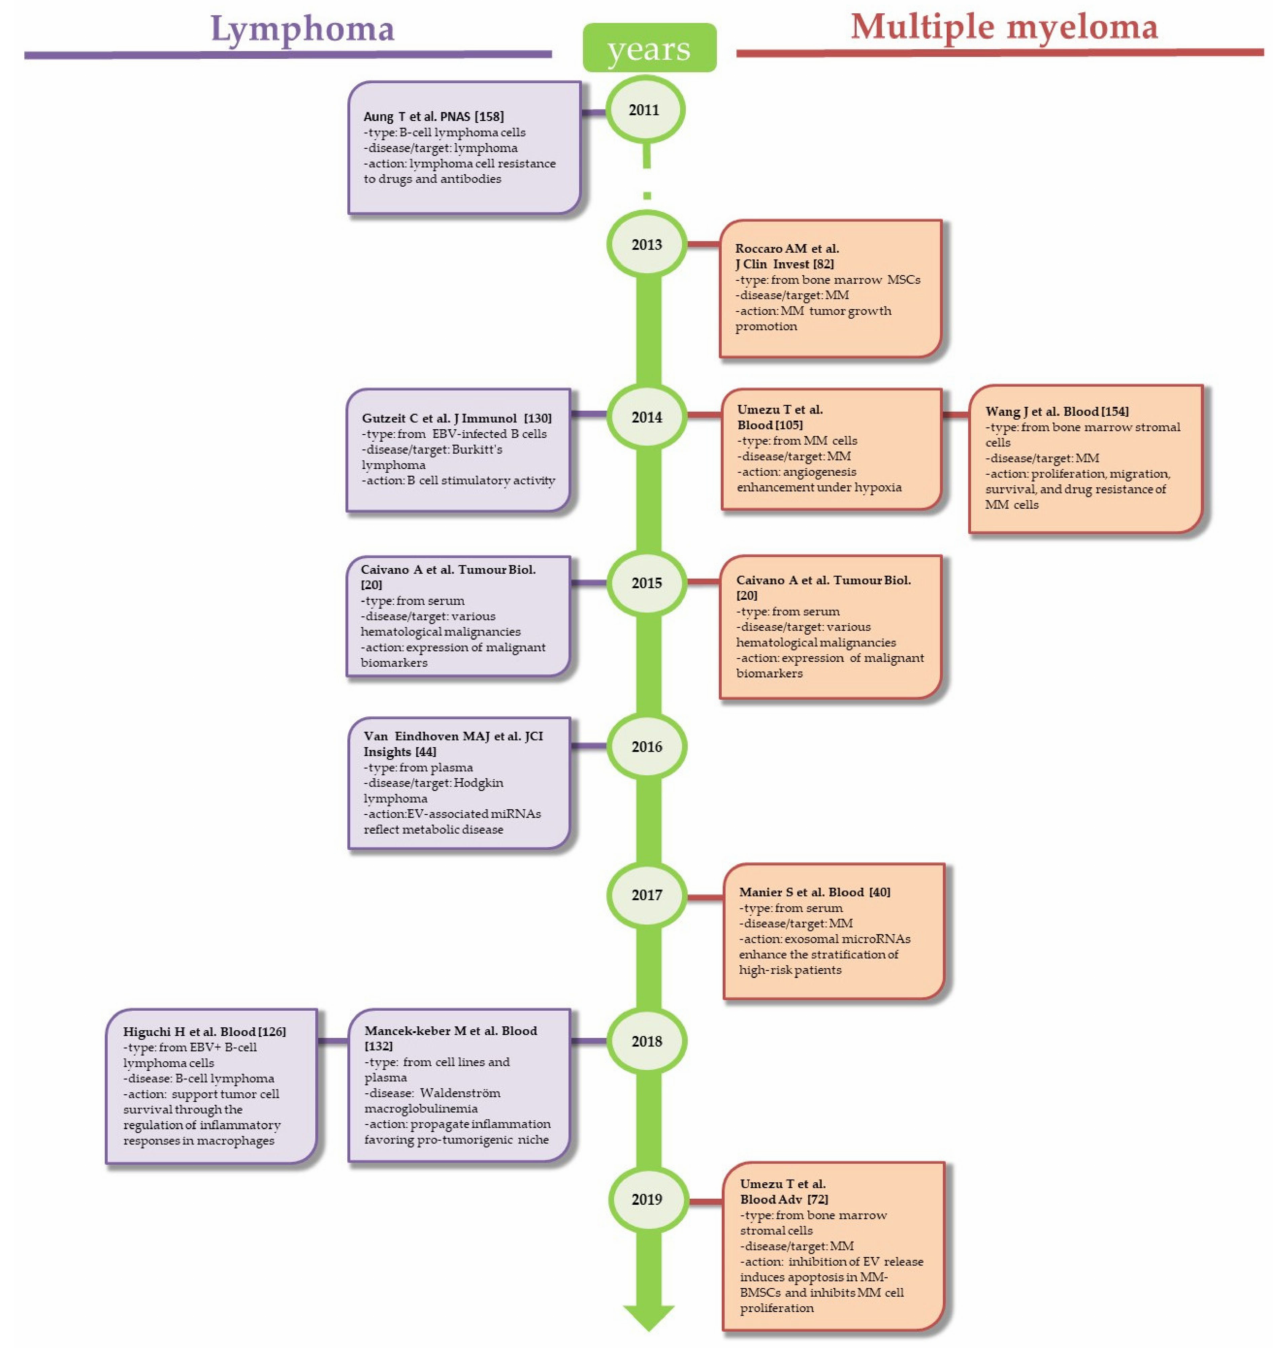
Figure 3. Timeline of key discoveries in EVs from Lymphoma and Multiple